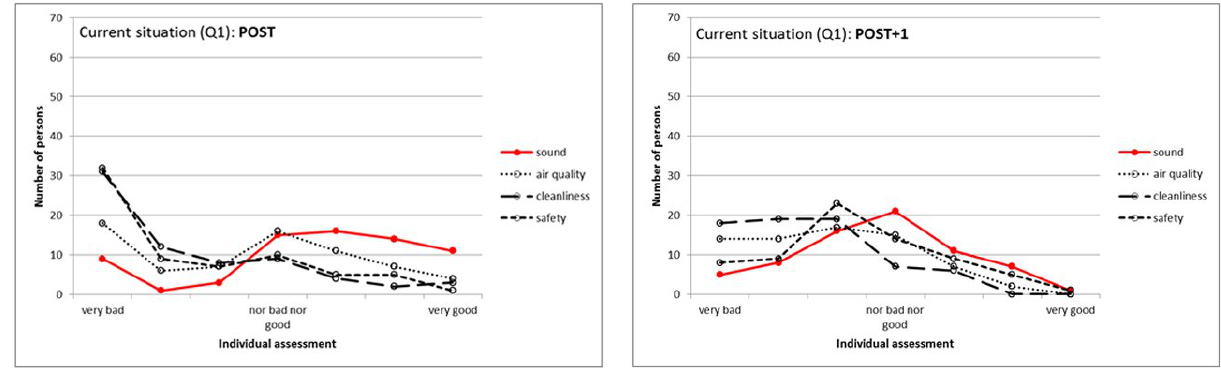
Figure 6: Individual responses’ distributions for Q1 for the four considered environmental aspects ( POST + 1 condition).